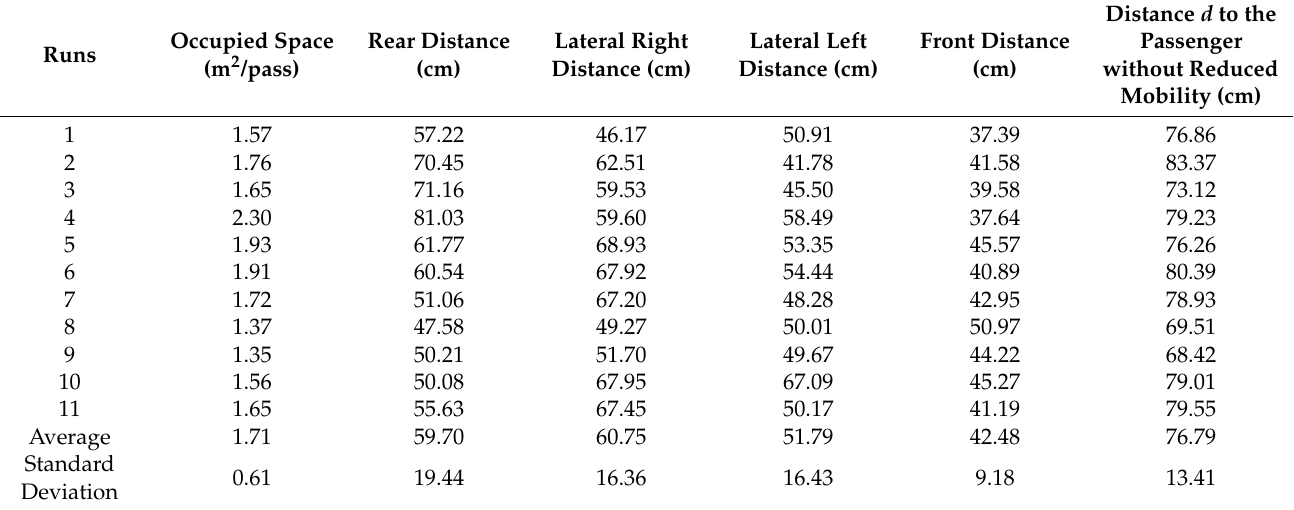
Table 5. Average space occupied by passengers without reduced mobility boarding the train.